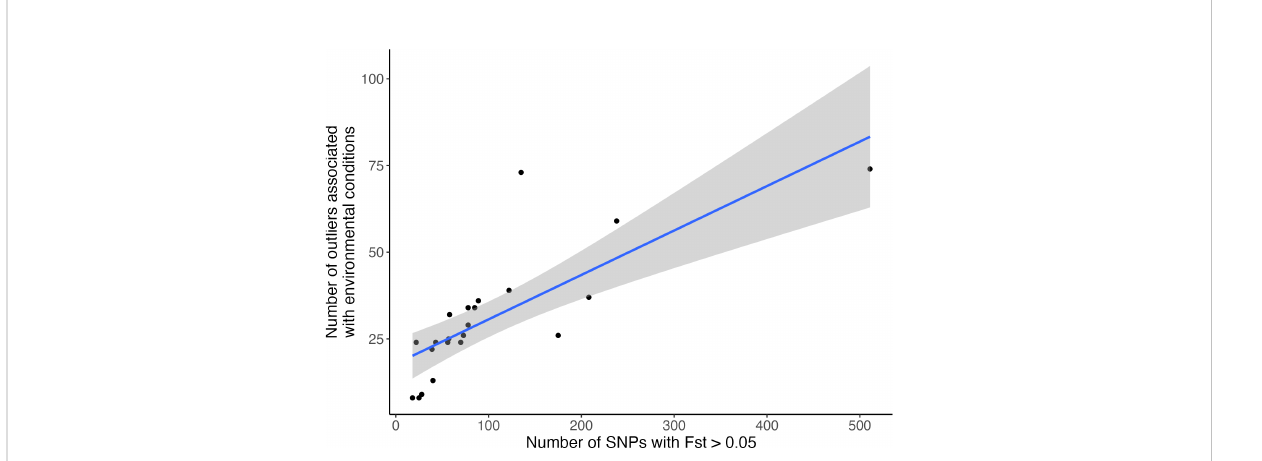
FIGURE 4 Relationship between the number of SNPs with Fst estimates higher than 0.05 and the number of SNPs detected in putative association with both bottom dissolved oxygen and temperature-related variables for each chromosome (adjusted r-squared = 0.51, p-value =